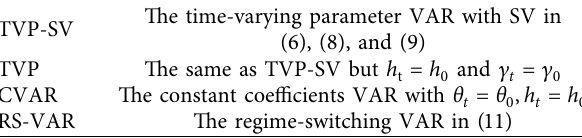
Table 2: Description of the statistical